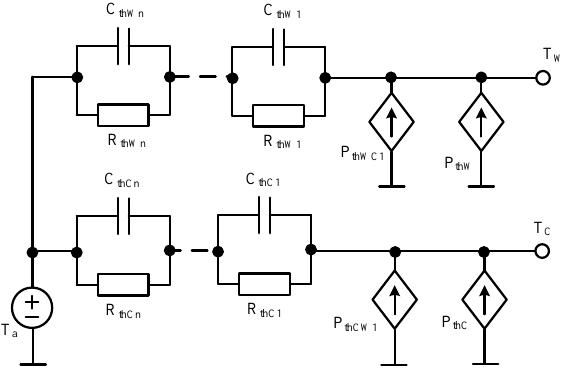
Figure 3. Network representation of the thermal model of a transformer proposed in [17].